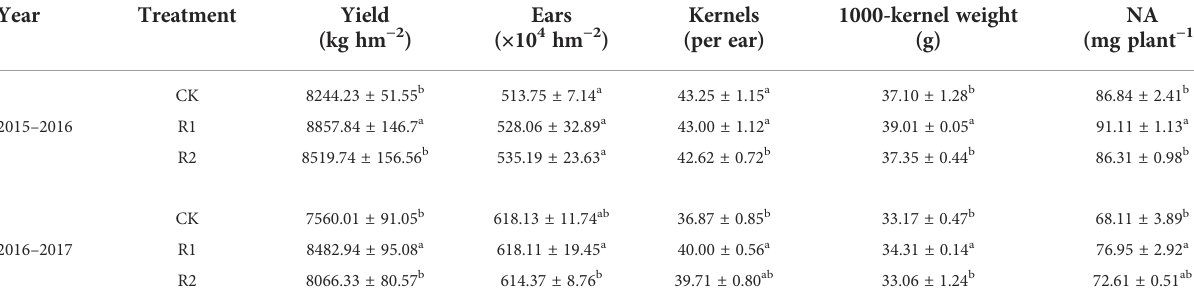
TABLE 1 Effects of row spacing on wheat yield, yield components, and nitrogen accumulation during two years. Year